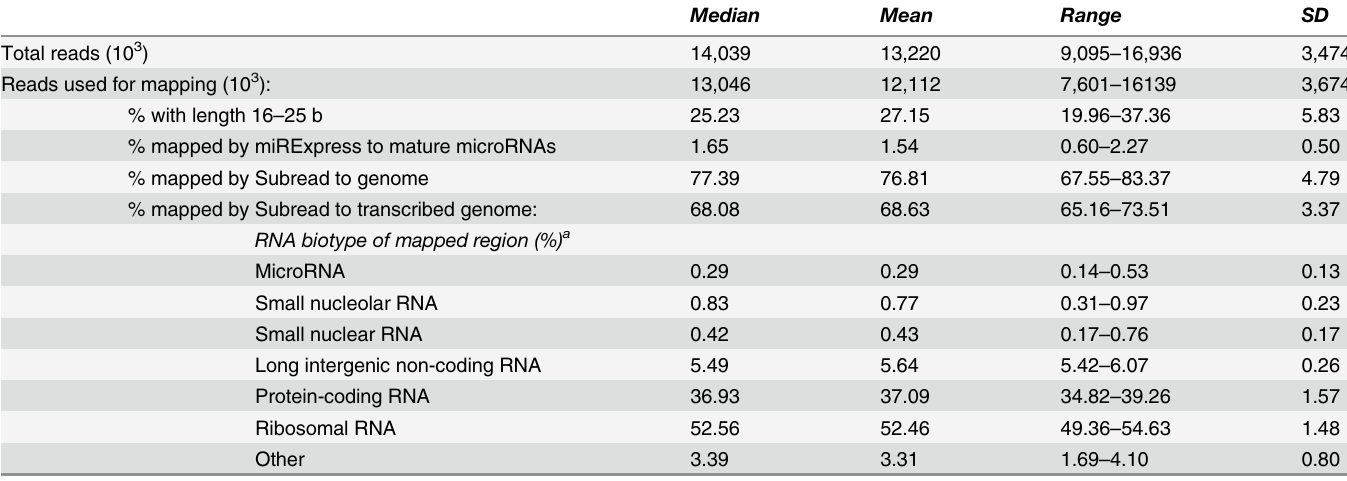
Table 1. Characteristics of small RNA sequencing data of the eight samples.